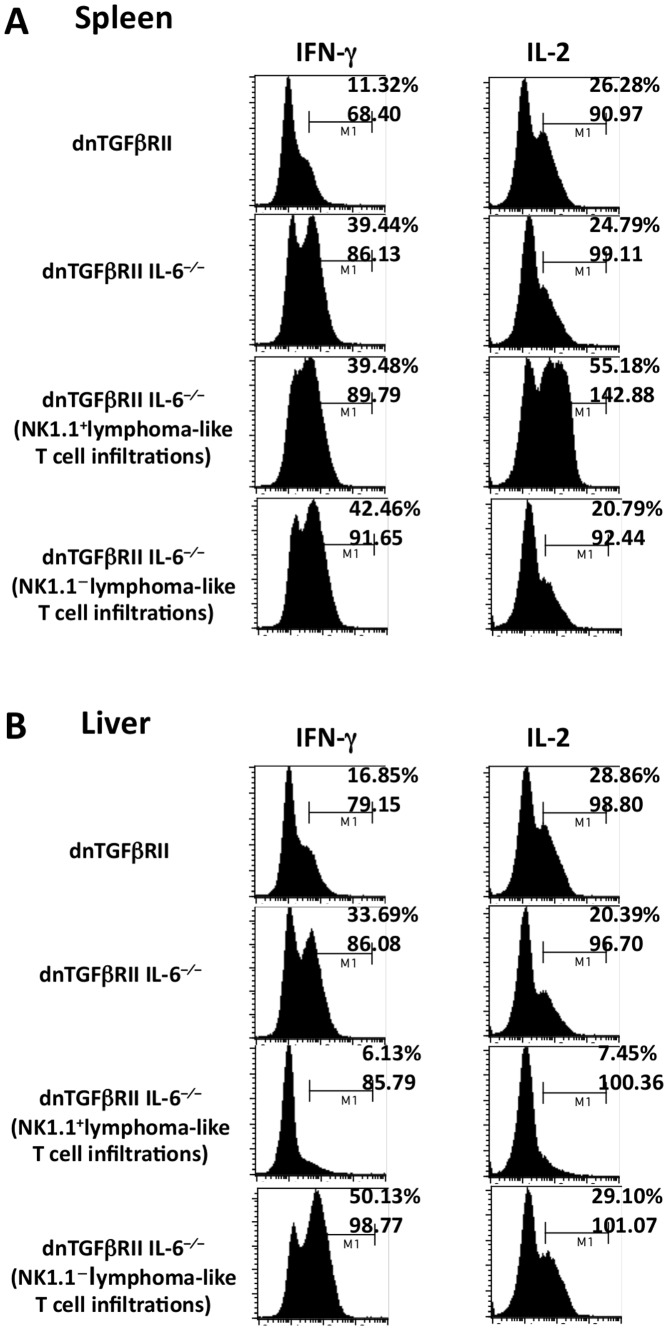
Cytokine profile of dnTGFβRII IL-6−/− mice with lymphomatous lesions.Intracellular cytokine production in hepatic (A) and splenic (B) T cells was determined by flow cytometry. The percentages and MFI of cytokine-producing T cells are shown. The frequency of IFN-γ and IL-2-producing T cells is lower in liver of dnTGFβRII IL-6−/− mice with a predominant NK1.1+ phenotype than dnTGFβRII IL-6−/− mice with a predominant NK1.1− phenotype (IFN-γ+ T: 6.13% vs. 50.13%; IL-2+ T: 7.45% vs. 29.10%). The data are representative of three independent experiments.